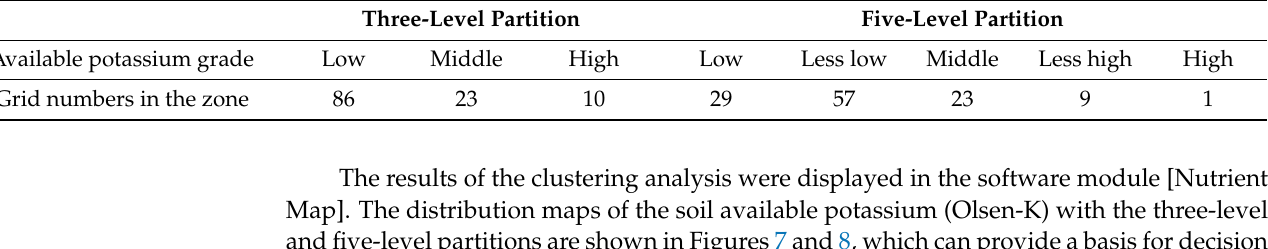
Table 1. Statistics on clustering partition of available potassium.